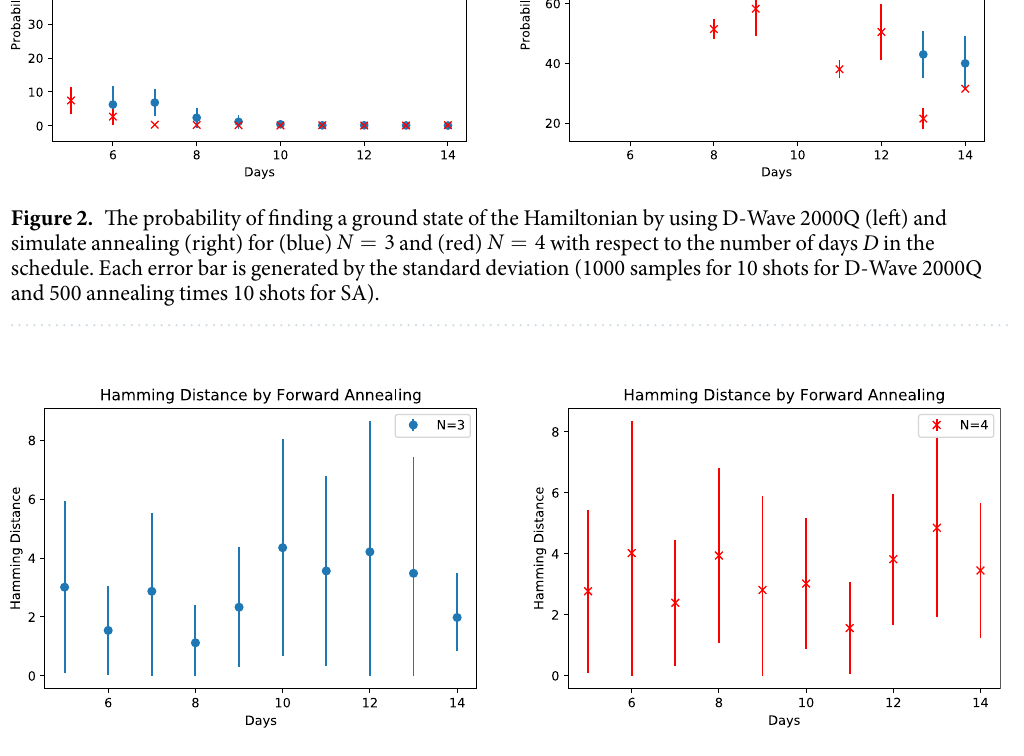
Figure 3. The Hamming distance between consecutive forward annealing solutions with respect to number of schedule days for (blue) = N 3 nurses and (red) = N 4 nurses. Error bars are based on the standard